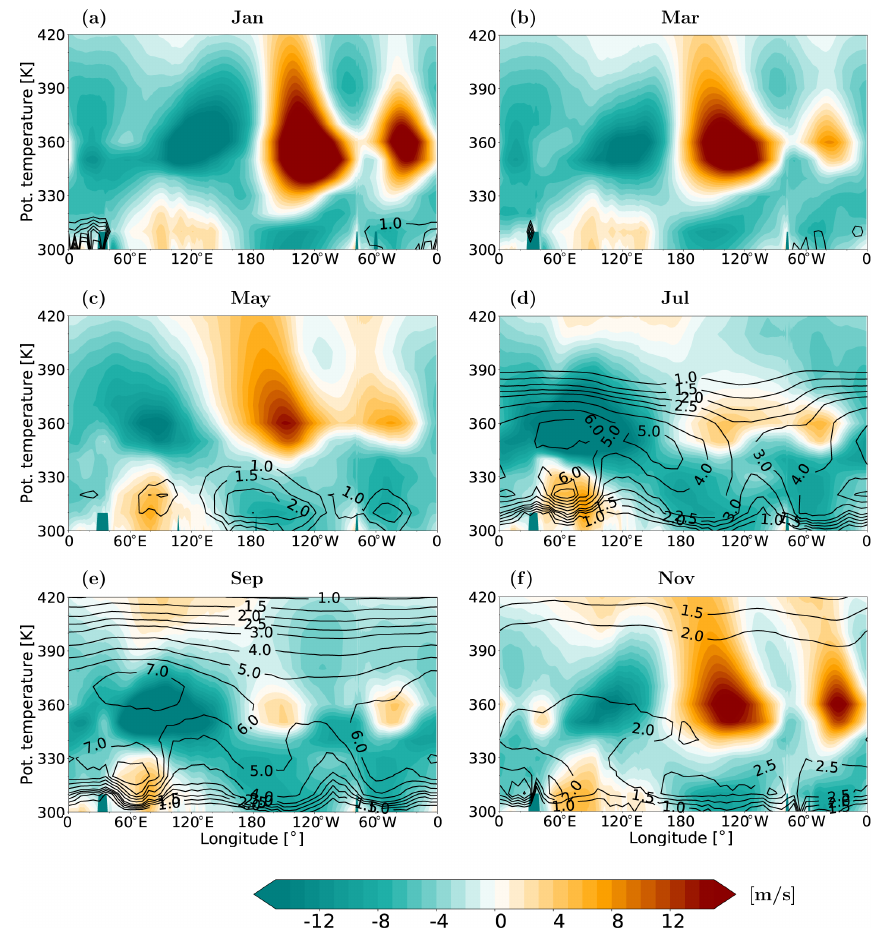
Figure 10. Longitude–potential-temperature cross section along the Equator of monthly mean zonal wind overplotted with the monthly zonal mean of NH extratropical young ( < 3 months) AMF (contours) over the domain of [6 ◦ N, 20 ◦ N] during